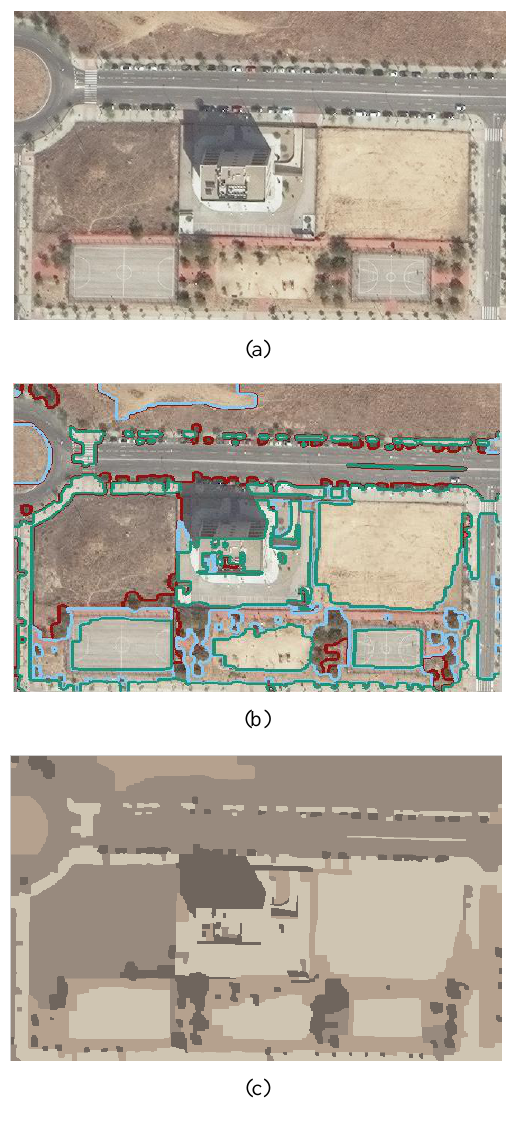
Figure 6. (a) The WorldView-3 image, (b) The result of segmentation obtained by the kernel graph cut algorithm, (c) The detection of shadow region of the building by the graph cut